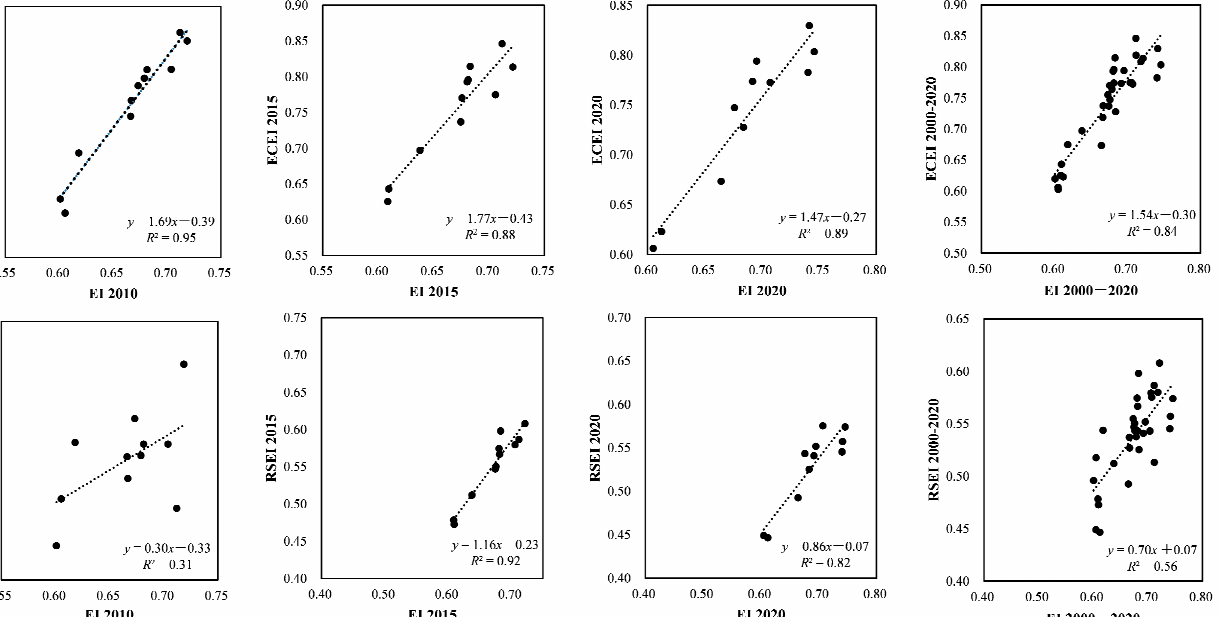
Figure 10. Spatial distribution map of average EI value from 2010 to 2020.